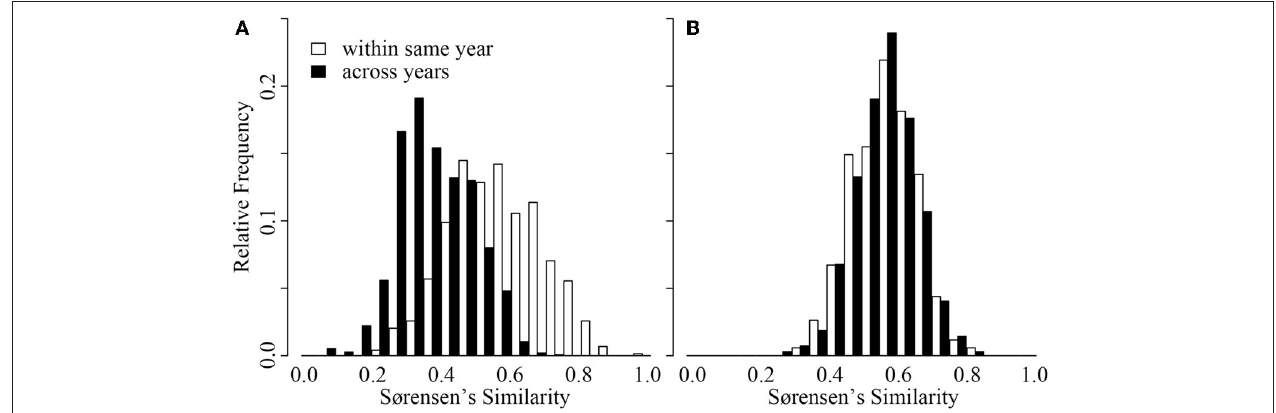
FIGURE 4 | Distribution of Sørensen’s similarity indices for samples collected within the same year (open bars) and samples collected across years (black bars) from Crystal Bog (A) and Lake Mendota (B).